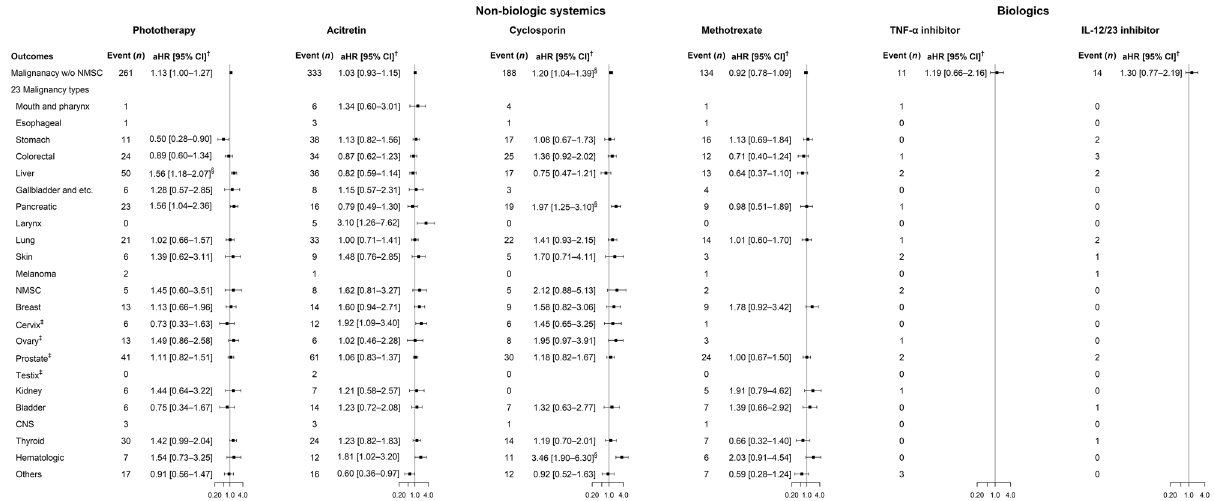
Figure 2. Risk of malignancy without NMSC in patients with psoriasis according to subcohorts of anti- psoriatic treatments compared with non-psoriasis participants. † Adjusted for age, sex, BMI, smoking status, family history of malignancy, Charlson Comorbidity Index, and alcohol use disorder (F10). ‡ Adjusted for age, BMI, smoking status, family history of malignancy, Charlson Comorbidity Index, and alcohol use disorder (F10). § The null hypothesis was rejected at false discovery rate adjusted P -value of 0.05. aHR, adjusted hazard